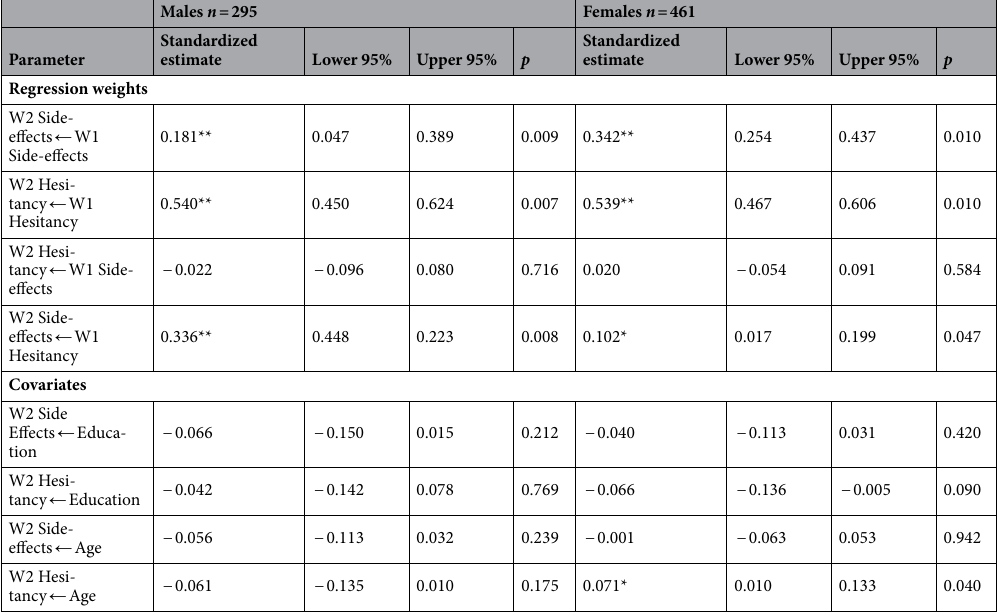
Males n = 295 Females n = 461 Standardized Parameter estimate Lower 95% Upper 95%